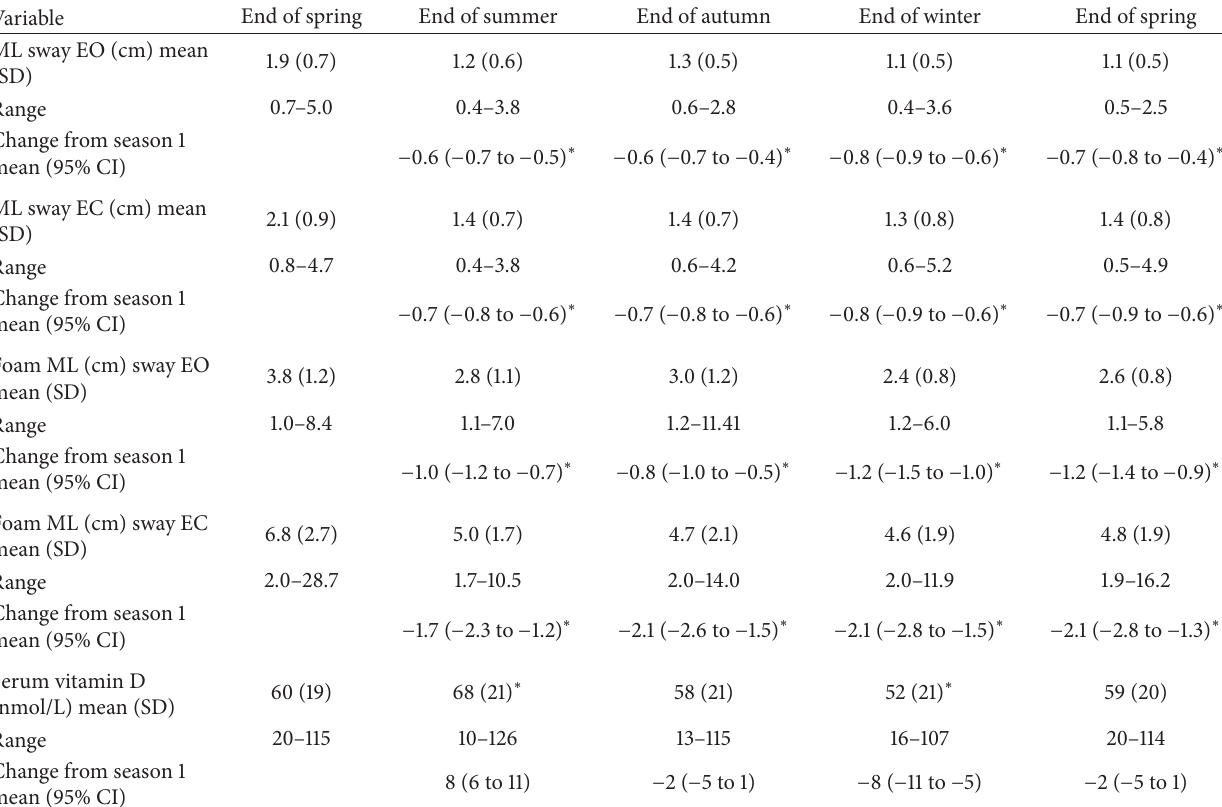
Table 1: Variations in serum vitamin D and dynamic and postural balance over 5